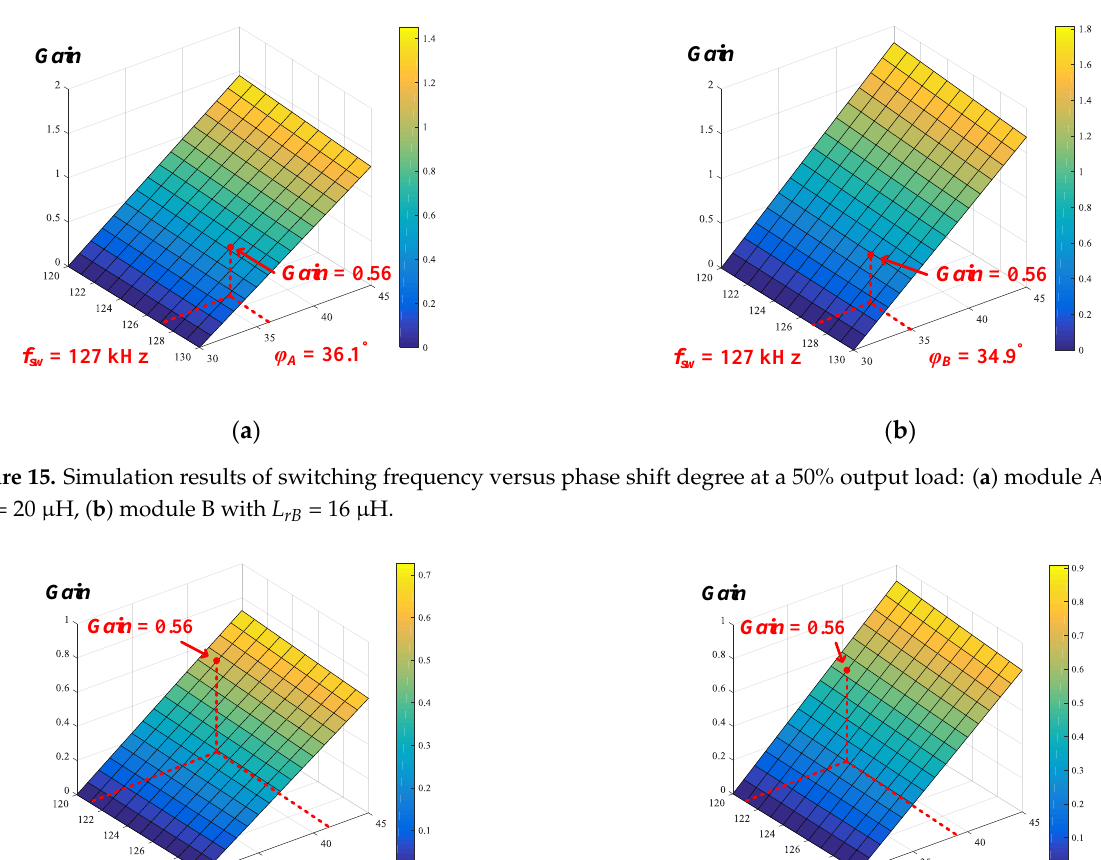
Figure 14. Simulation results of switching frequency versus phase shift degree at a 25% output load: ( a ) module A with L rA = 20 μH, ( b ) module B with L rB = 16 μH.